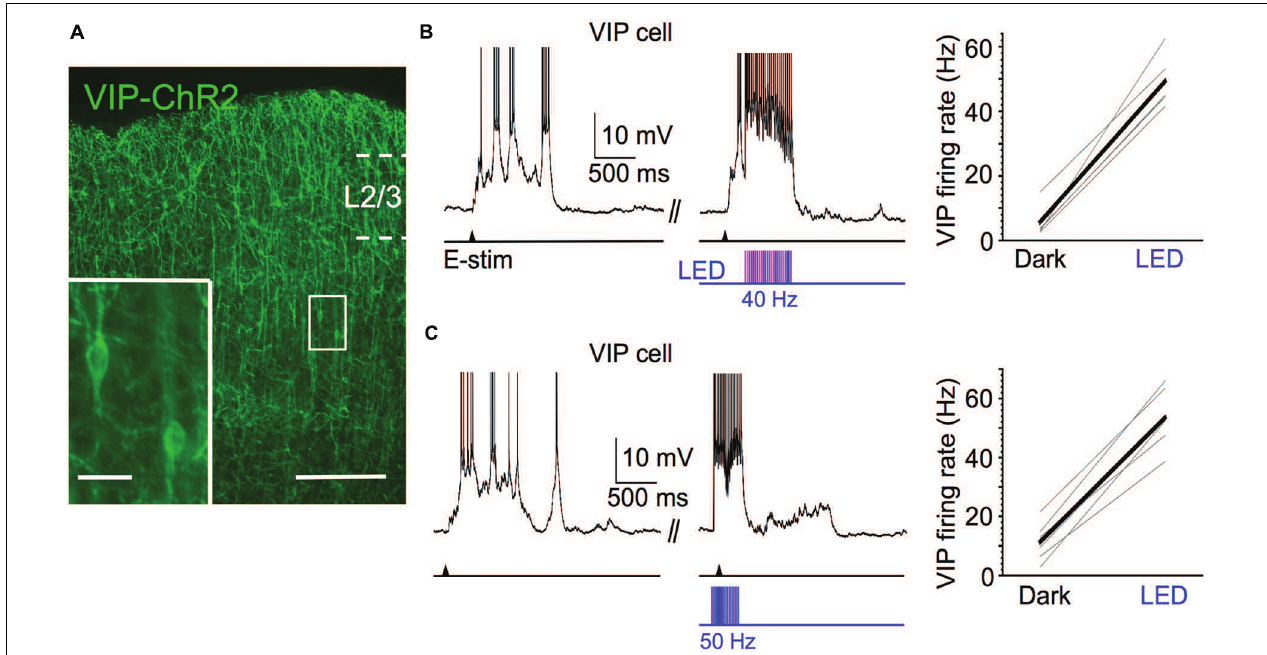
FIGURE 6 | Efficacy of ChR2 expression in VIP cells. (A) Fluorescent image of ChR2-EYFP-expressing VIP cells in superficial layers of barrel cortex; scale bar = 200 µ m. Inset: expanded view of 2 ChR2-expressing VIP cells, scale bar = 20 µ m. (B) 40 Hz light pulse trains (pulse width = 5ms) effectively entrain spiking of ChR2-expressing VIP cells. Voltage trace of example VIP cell is shown to left (action potentials truncated). Shown to right are population data ( n = 6 cells; Dark: 5.7 ± 1.9 Hz, LED: 49.3 ± 3.1 Hz, P = 4.4 × 10 − 6 , paired t -test). (C) As in (A) , but light pulse trains are 50 Hz and given 100 ms before electrical stimulation and left on for 250 ms after electrical stimulation. Voltage trace of example VIP cell is shown to left (action potentials truncated). Shown to right are population data ( n = 6 cells; Dark: 11.4 ± 2.7 Hz, LED: 53.6 ± 4.1 Hz, P = 4.3 × 10 − 6 , paired t